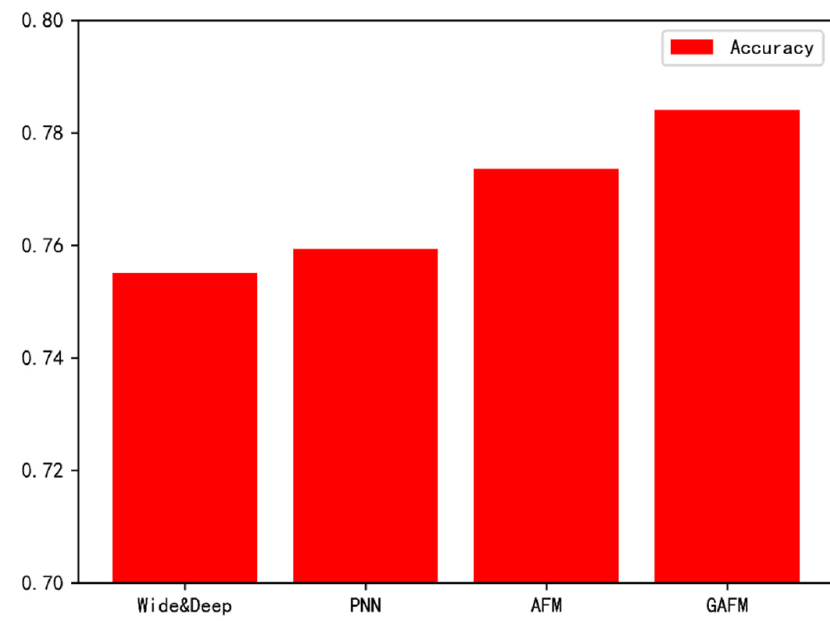
Figure 18. The accuracy of each model is compared. It is obvious from Figure 19 that compared with dataset 1, the running time of GAFM on dataset 2 is significantly less than that of other models, which has obvious advantage.